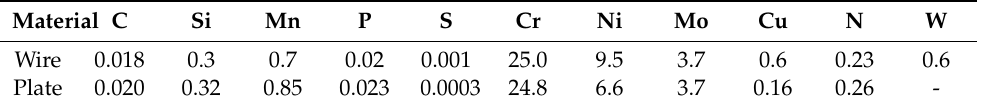
Table 1. Chemical composition of selected welding wire and building plate (in